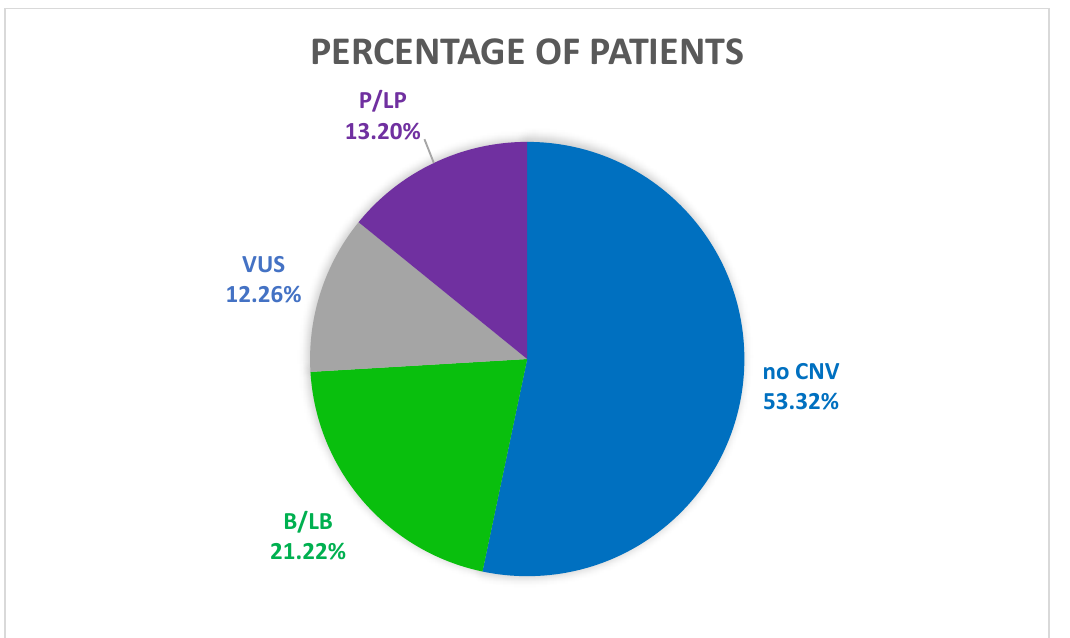
Figure 3. Percentage of individuals with P/LP, B/LB, and those with no CNVs found. Out of the 212 patients, 28 carried P/LP CNVs; 45/212 carried benign CNVs, and 26/212 carried VUS, while 113 (53.32%) did not show any CNVs.